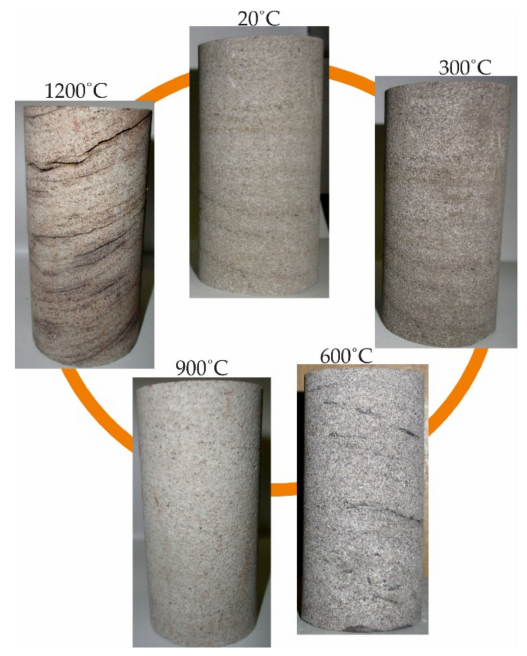
Figure 4. Sandstone heated at high